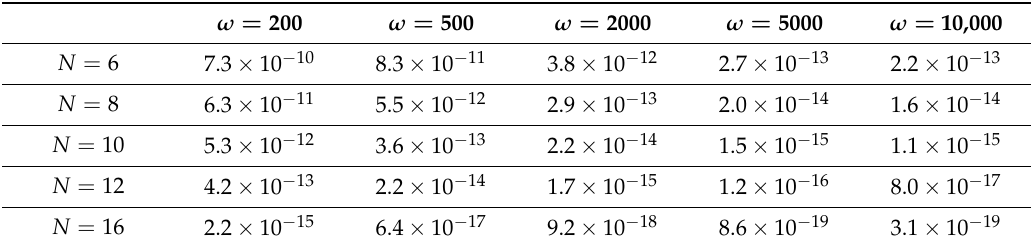
Table 6. Absolute errors of 2DSC-Levin for Example